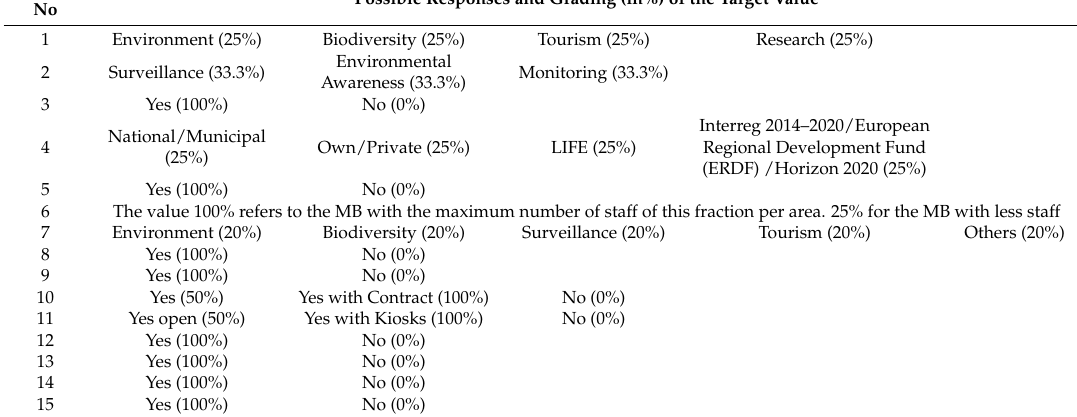
Table A1. Gap analysis queries on Management Practices are presented in the same sequence as presented in Table 1 along with the grading of each query in percentage (%) depending on possible answers. The final grading is the sum of the grades of all available answer options.